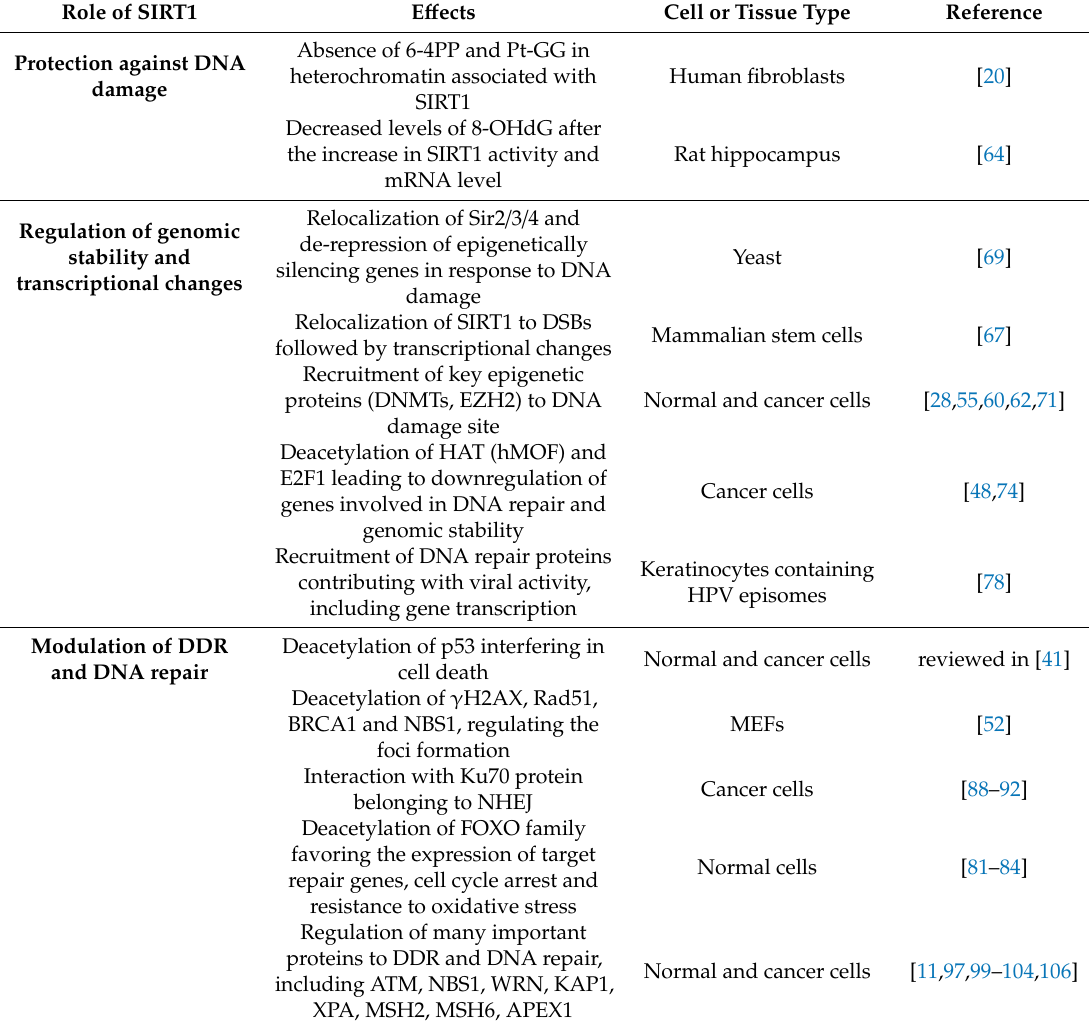
Table 1. The role of SIRT1 and its e ff ects in response to DNA